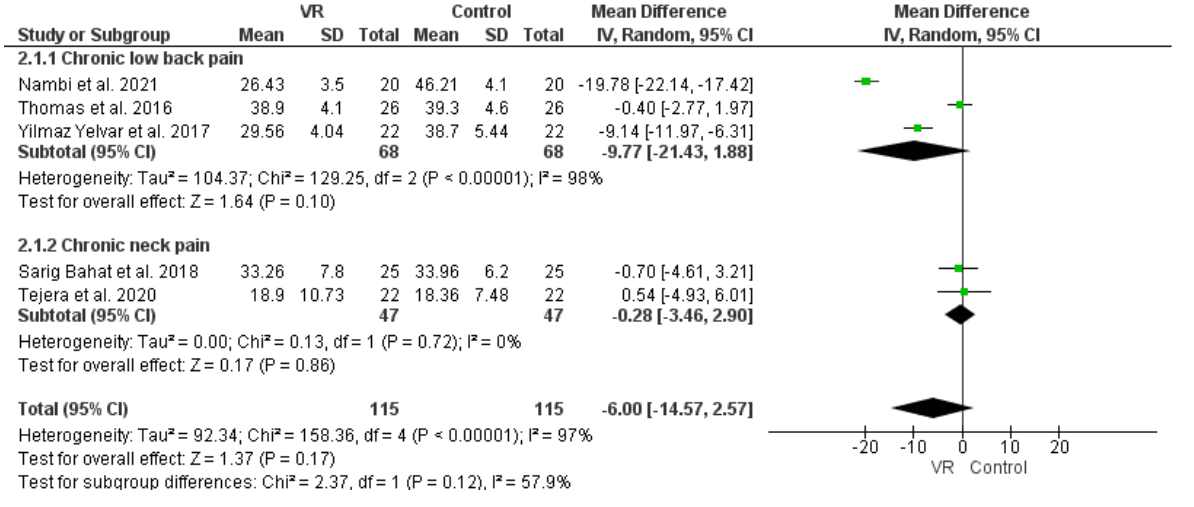
Figure 6. Effect of VR and control intervention on TSK outcome. Green squares represent mean difference for each study, while black rhombus represents the aggregated average of the mean differences.